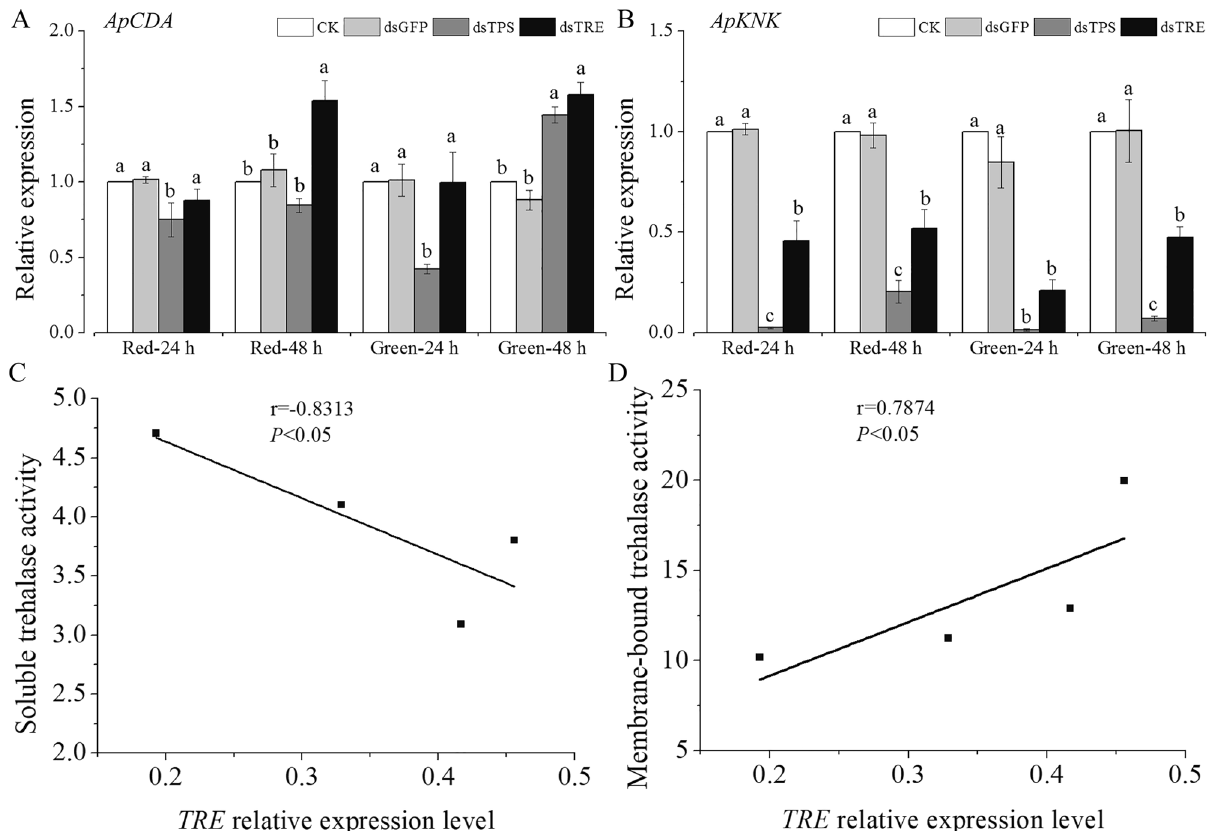
Figure 6. The expression levels of ApCDA and ApKNK at 24 h and 48 h after RNAi of ApTPS and ApTRE . ( A ) Chitin deacetylase gene, ( B ) Chitin-binding protein Knickkopf gene, ( C , D ) The correlation analyses between the trehalase activity and the expression of ApTRE . Each point in the figure represents a sample, and the P -values and the correlation coefficient r are presented. Bivariate correlations between variables were calculated using Spearman’s rank correlation coefficients. CK , the normal diet; dsGFP , the GFP-dsRNA treatment; dsTPS , the TPS-dsRNA treatment; dsTRE , the TRE-dsRNA treatment. Each bar represents the Means ± SEM from three biological replicates and three technical replicates and the data were analyzed using one-way analysis of variance (ANOVA), followed by the Tukey–Kramer test. The mRNA expression level in the artificial diet group was designated as control, different letters above the error bars indicate significant differences ( P <